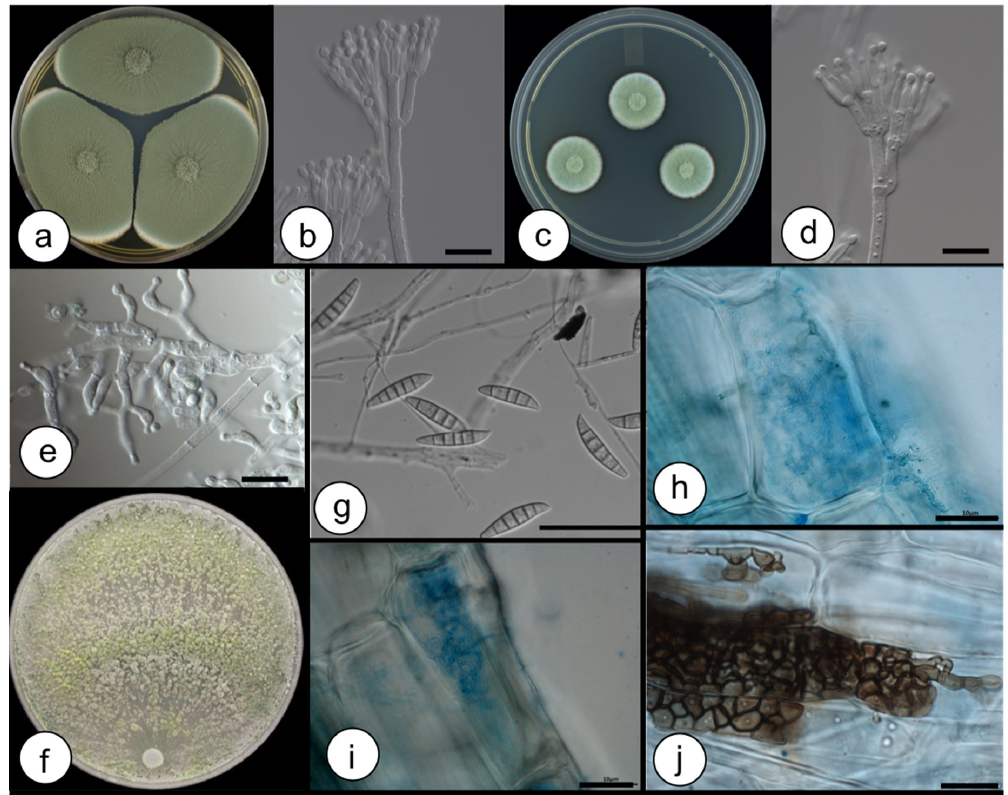
Figure 4. Examples of fungi isolated from fynbos soils and plants. ( a – b ) Colony morphology and conidiophore morphology of Penicilium crustosum isolated from fynbos soil (photo: CM Visagie). ( c , d ) Colony morphology and conidiophore morphology of Penicilium pumilaemali isolated from fynbos soil (photo: CM Visagie). ( e , f ) Conidiophore morphology and colony morphology of Trichoderma saturnispora isolated from fynbos soil (photo: IH du Plessis). ( g ) Conidia of an undescribed Fusarium sp. isolated from Table Mountain (photo: V Bushula). ( h , i ) Mycorrhizal structures observed in Erica mammosa hair roots (photo: K Wirth). j. Dark septate endophytes observed in Erica